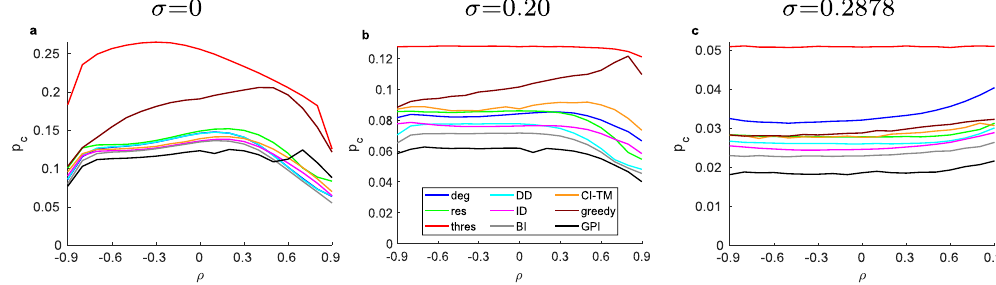
Figure 2. Initiator fraction p c required to reach spread S eq = 0.5 vs. degree assortativity ρ for graphs with N = 10,000 and 〈 k 〉 = 10 for ( a ) σ = 0, for ( b ) σ = 0.20, and for ( c ) σ = 0.2887 with φ = . 0 5 , averaged for 500 different network realizations (except for the GPI which is 20) each with a different threshold generation.